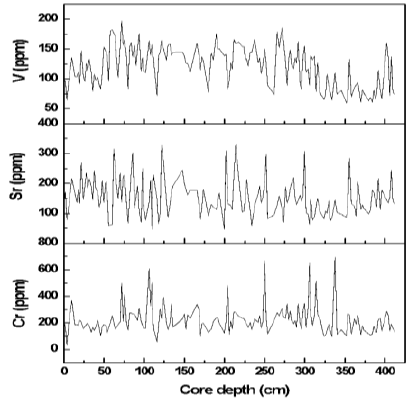
Figure 4: Down core variations of Cr, Sr and